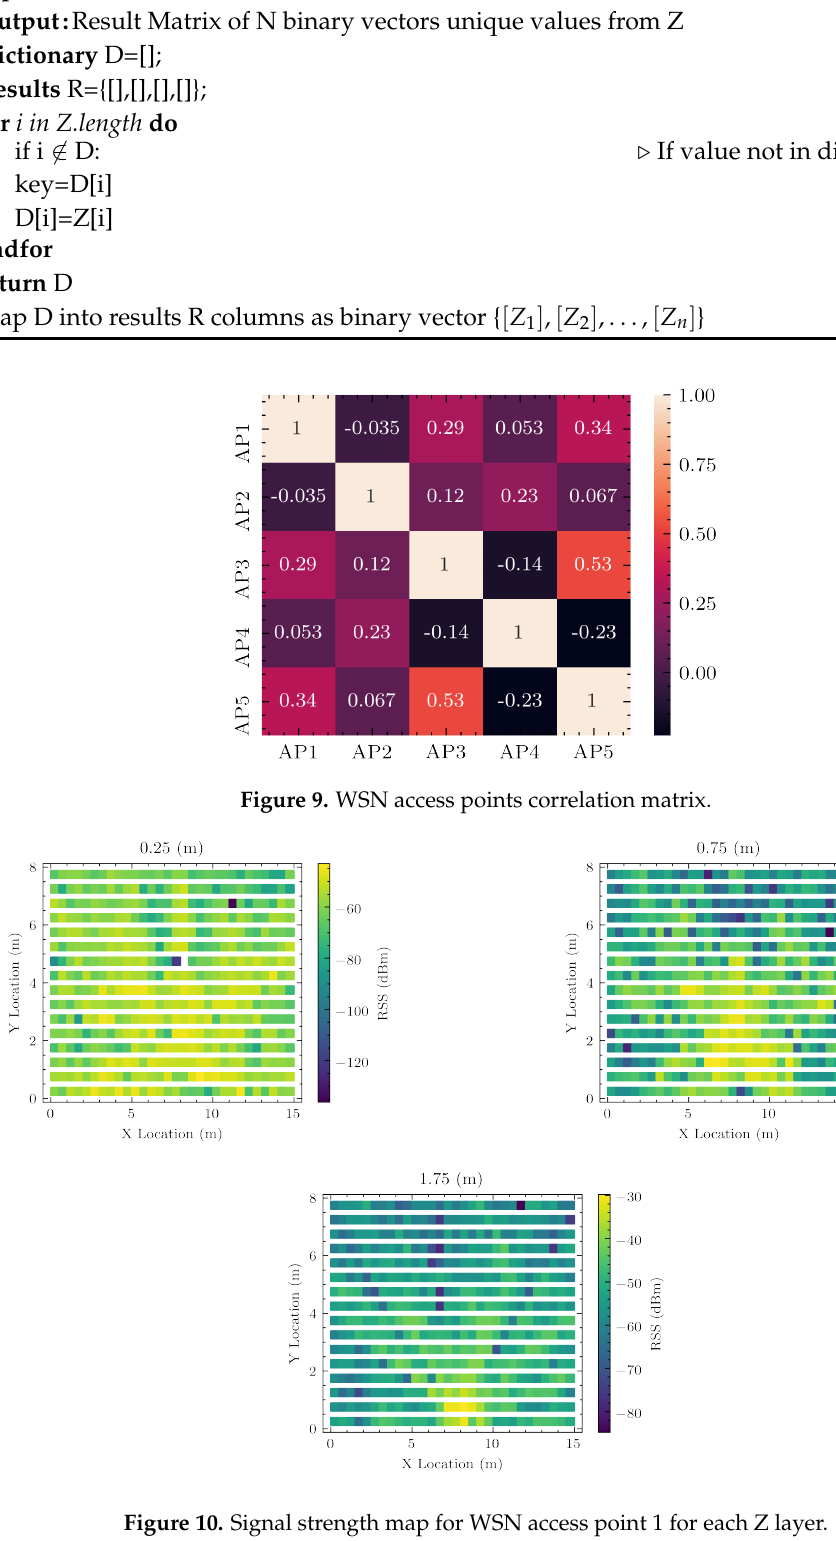
Figure 10. Signal strength map for WSN access point 1 for each Z